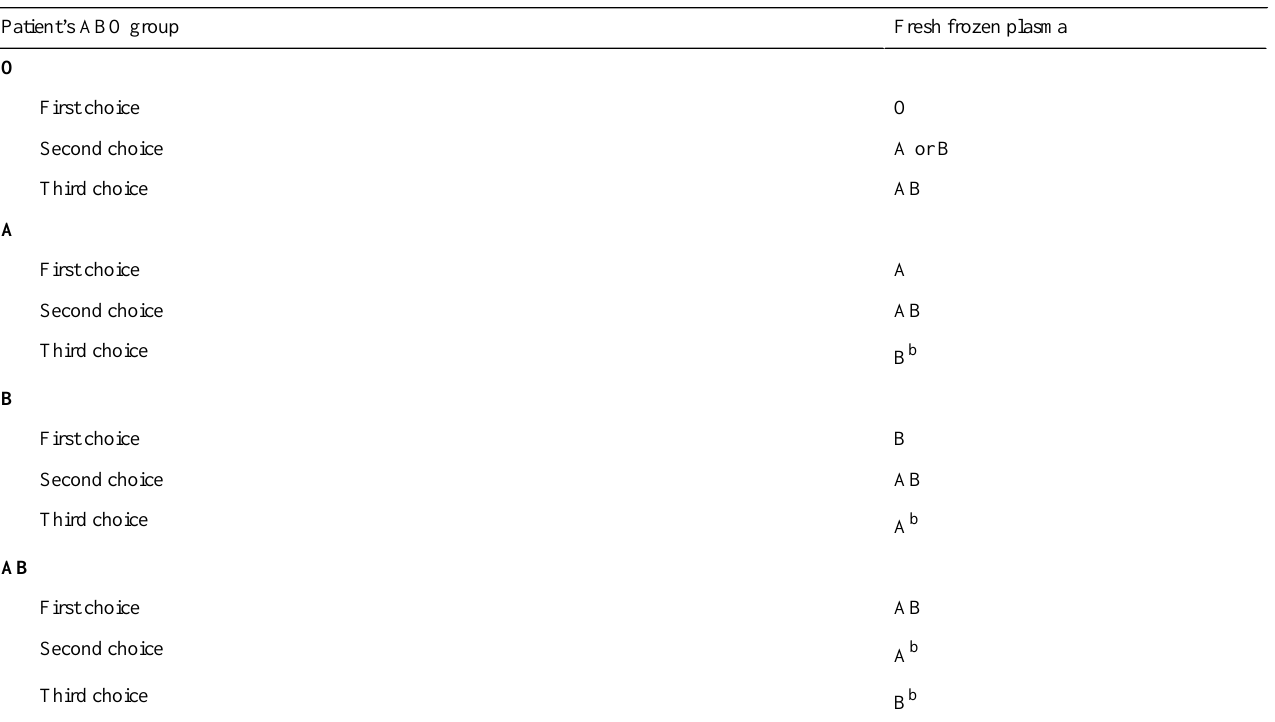
Table 2. ABO group selection order for transfusion of plasma.